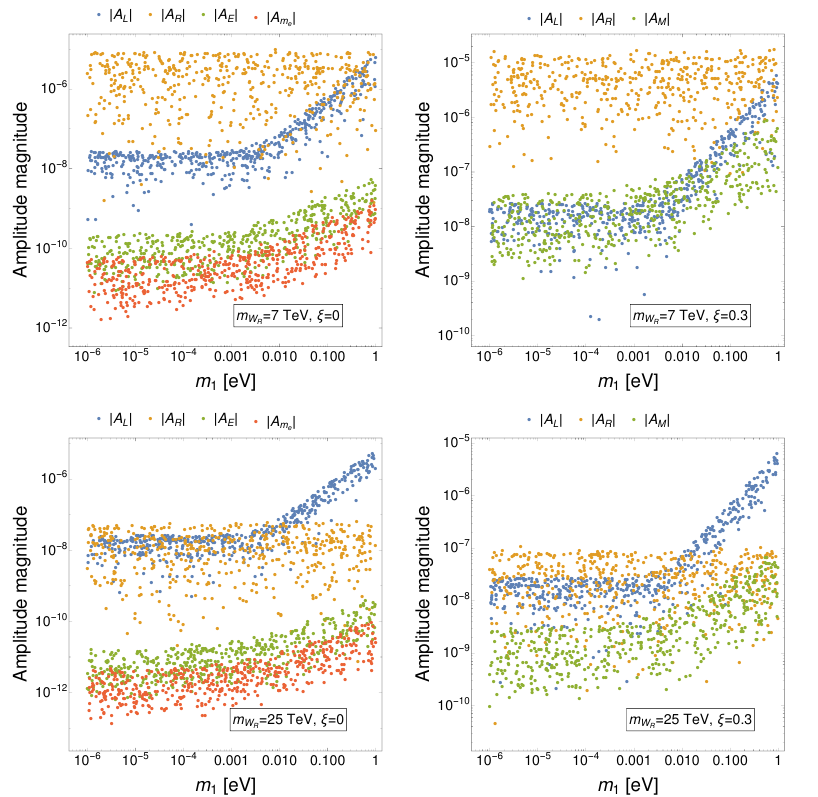
Figure 7. Amplitude magnitudes as a function of the lightest neutrino mass m 1 in the type-I seesaw scenario. Active neutrinos are assumed to be in the NH, and the sterile neutrino masses are varied from 10 MeV to 1 TeV. The right-handed gauge bosons mass is set to be m ( 25 TeV) in the upper (lower) panels with ξ = 0 (left) and 0 . 3 (right). In the left panels, |A |A E | and |A m | are shown in blue, orange, green and red, respectively; in the right panels, |A L | , e |A R | and |A M | are shown in blue, orange and green,